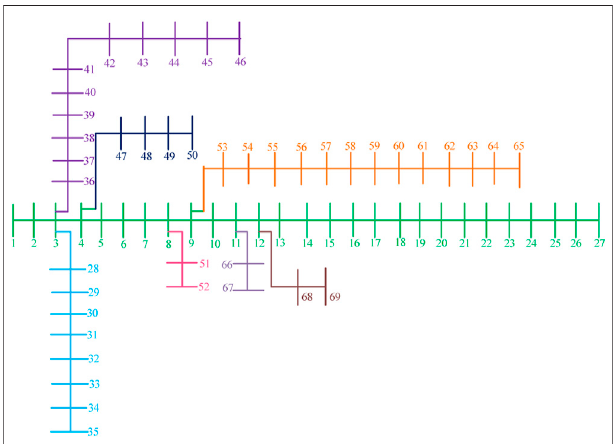
FIGURE 6 | IEEE 69-bus distribution network.